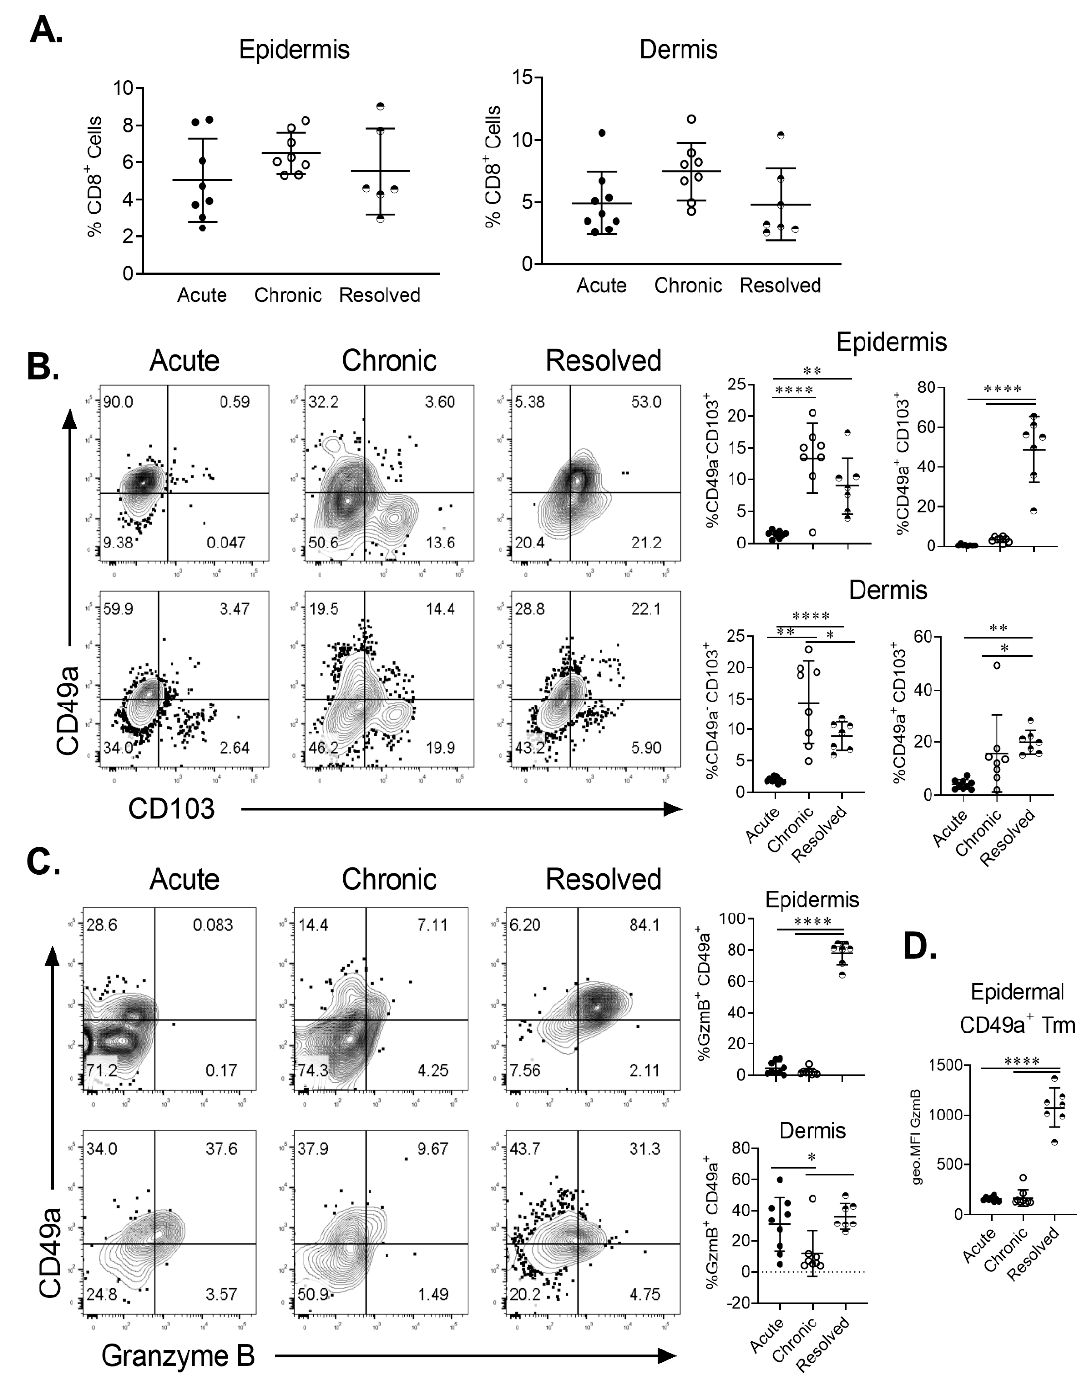
Figure 3. Fluorescence-activated cell sorting (FACS) analysis of Trm cell levels in skin of imiquimod-induced acute, chronic and resolved psoriasiform dermatitis. ( A ) Levels of CD8 + T cells in the dermis and epidermis of psoriasis-like murine skin expressed as percentage of live cell. ( B ) Representative FACS plots of CD49a vs. CD103 staining on CD8 + T cells found in the epidermis (top) or dermis (bottom). Proportion of CD49a + CD103 + and CD49a − CD103 + Trm cells was quantitated for each condition. ( C ) Representative FACS plots of CD49a vs. GzmB staining on CD103 + CD8 + T cells found in the epidermis (top) or dermis (bottom). The proportion of GzmB expressing CD49a + Trm cells was quantitated. ( D ) Quantitation of GzmB geometric mean expression by epidermal CD49a + Trm cells. Each dot represents one mouse skin sample ( n = 8 / group). Data are presented as mean ± SD. * p < 0.05, ** p < 0.01, **** p < 0.0001.